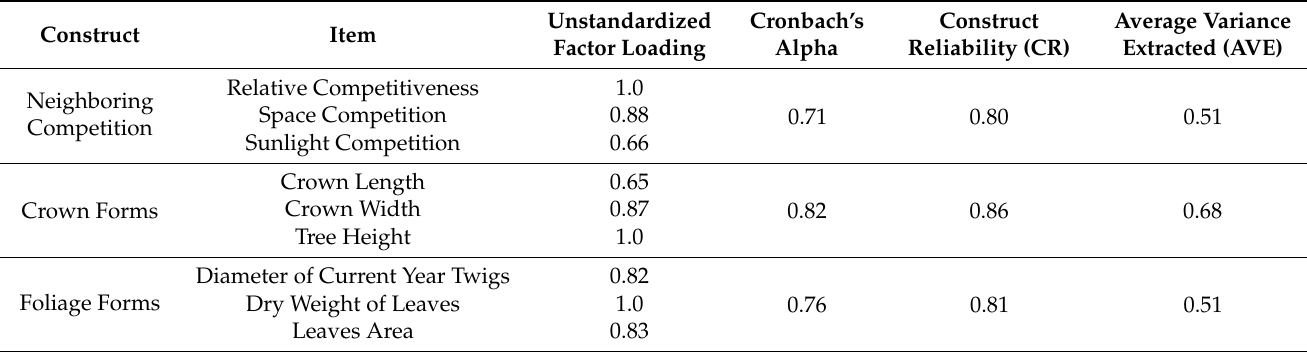
Table 4. Results of confirmatory factor analysis for the reliability and validity of